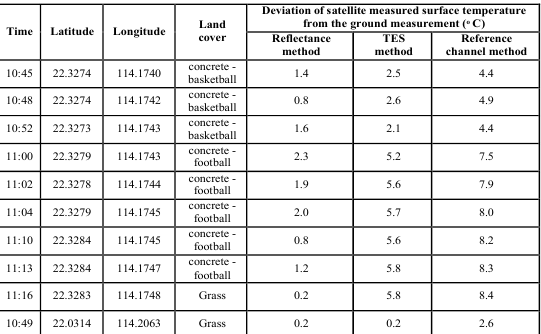
Table 3.1. Difference between Satellite measured (Applied different emissivity technique) and field measured temperature and the detail of measurement